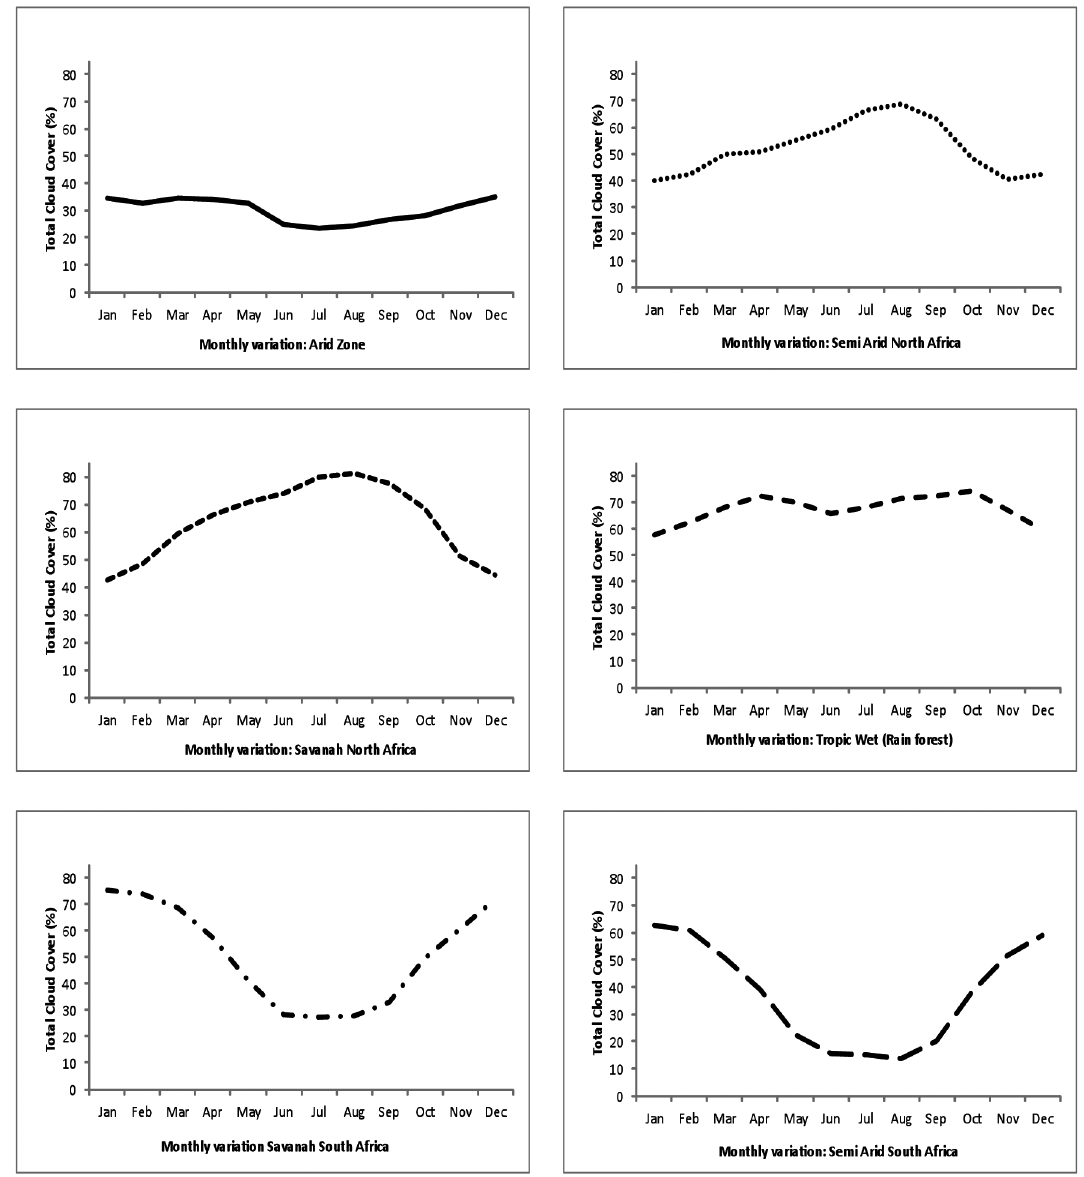
Figure 6. Monthly distribution of total cloud cover in the six major climatic